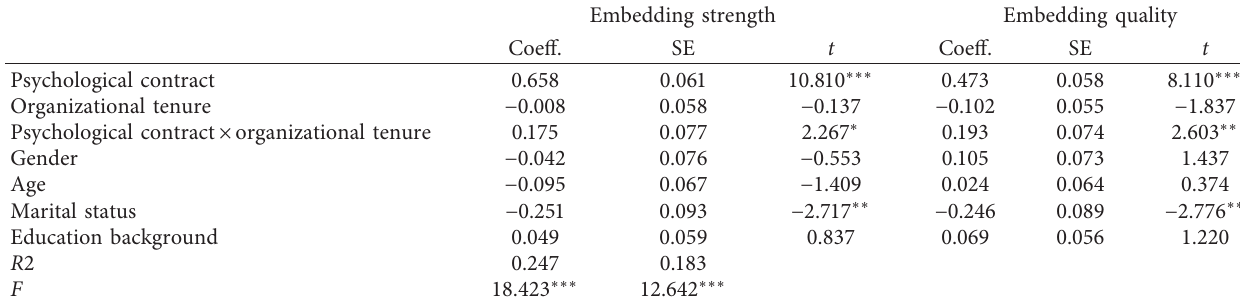
Table 5: Regression analysis results for interactive